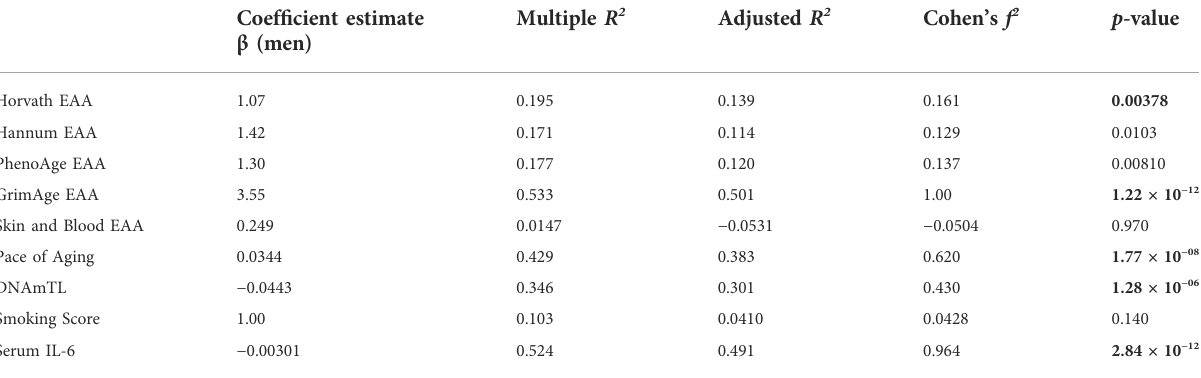
TABLE 3 Positive Epigenetic Age Acceleration (EAA) is evident in men from the Blue Zone relative to women from the Blue Zone. The coef fi cient estimate indicates the linear model β coef fi cient associated with the speci fi ed independent variable in brackets, and Cohen ’ s f 2 effect size based on the Adjusted R 2 of the linear model. Bolded p -values indicate signi fi cance (corrected p -value < 0.00556). Coef fi cient estimate Multiple R 2 Adjusted R 2 Cohen ’ s f 2 p β (men)